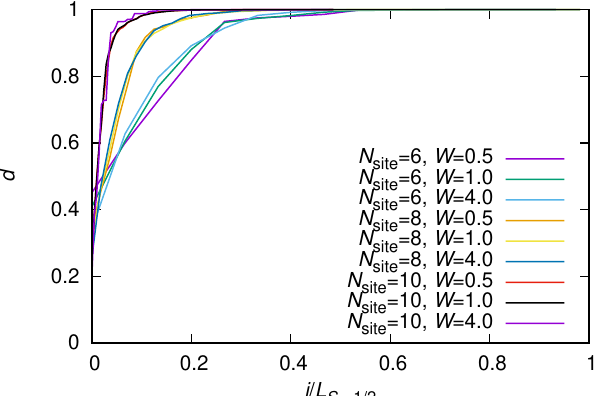
P N site P j jh E j (cid:27) + j E 0 ; 0 ij 2 . Averages over 100 samples i; 1 = 2 k =1 i =0 k N site , where L is the S z =1 = 2 S z =1 = 2